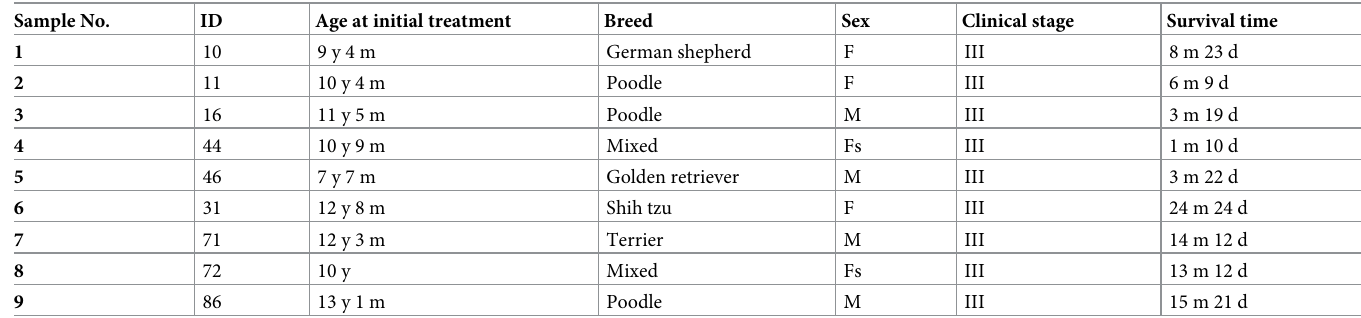
Table 1. Patient history.